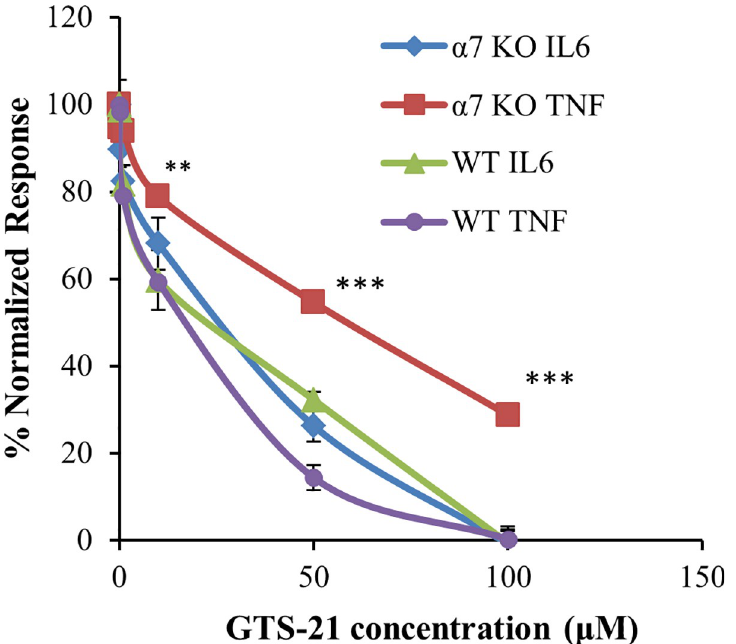
Fig 3. GTS-21 attenuates IL6 and TNF secretion in macrophages from WT and α 7 nAChR knockout mice. Macrophages from WT and α 7 nAChR knockout mice were isolated and activated by LPS before assaying the amount of IL6 and TNF release measured by ELISA as indicated in the methods section. Quadruplicate responses are normalized to cytokine release by LPS in the absence of GTS-21. A repetition of this experiment yielded similar results. One-way ANOVA (analysis of variance) with post-hoc Tukey HSD (honestly significant difference) test used to compare differences between multiple treatment groups. �� P < 0.01, ��� P < 0.001 for the a7 KO TNF curve, other curves had similar P values (not